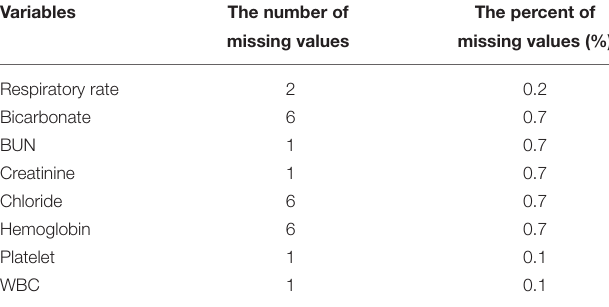
TABLE 1 | Details of missing